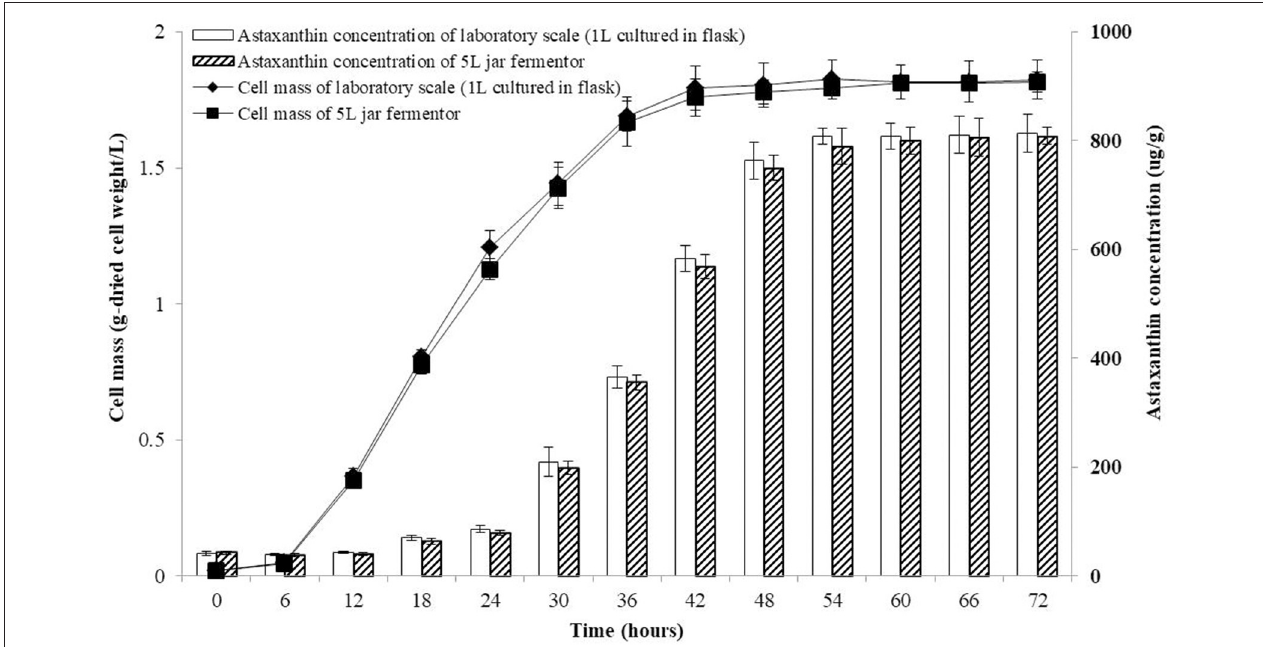
FIGURE 8 | Growth and astaxanthin production curve of the co-culture of Paracoccus haeundaensis and Lactobacillus fermentum at the laboratory scale and in a 5L jar